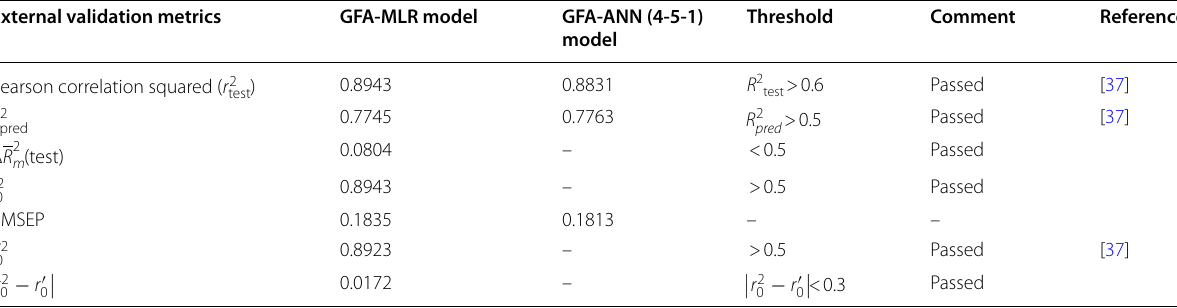
Table 3 External validation parameters of the 2D-QSAR models External validation